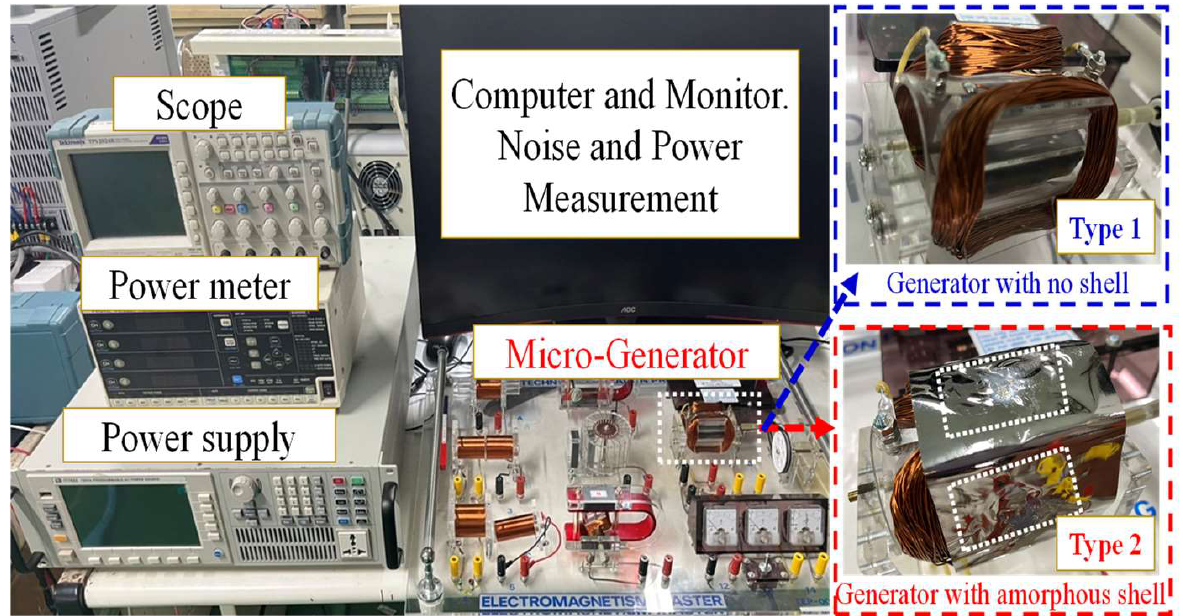
Figure 8. Experimental environment and setup.